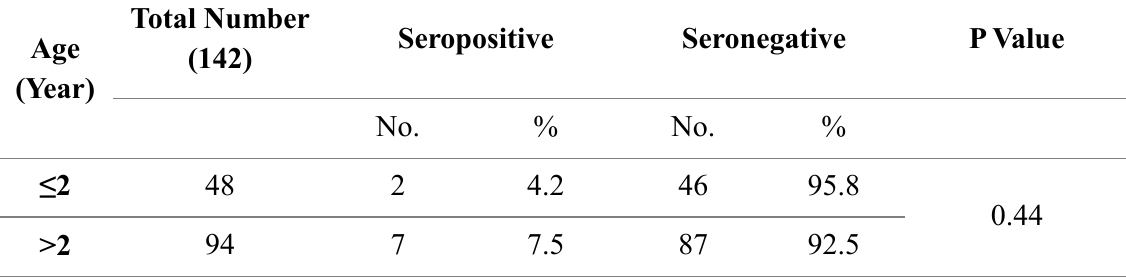
Table 2. The Seropositivity of Anti F. hepatica IgG antibodies in Sera of Goats by ELISA according to the age